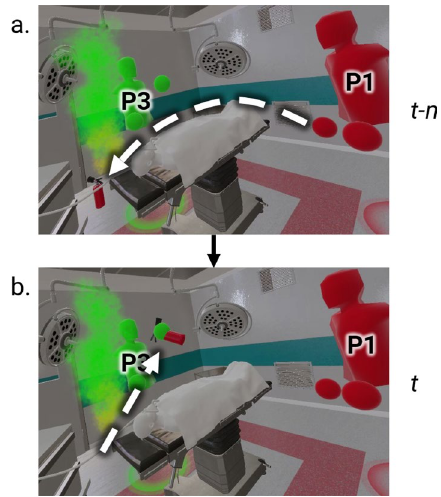
Figure 8. ( a ) P3 (left) appears to drop the extinguisher thrown from P1 (right) from P2’s perspective. ( b ) P3 actually catches it, but the latency between P3 and P1 gives an incorrect series of